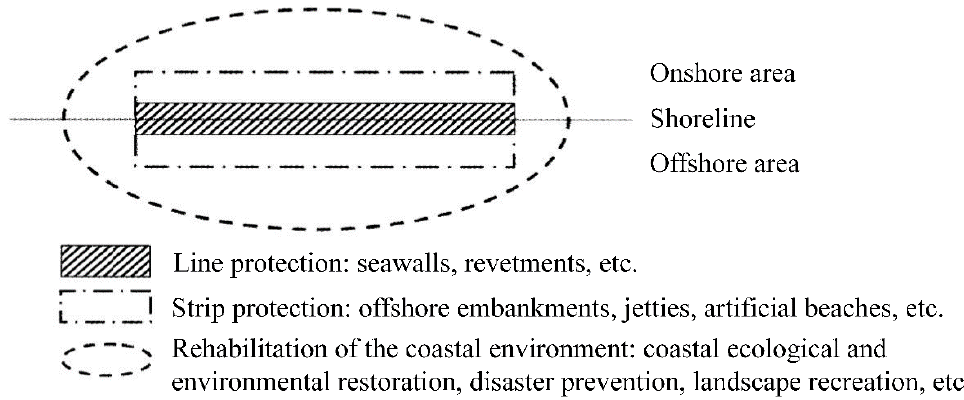
Figure 4. Research direction for coastal buffer zone management [29].